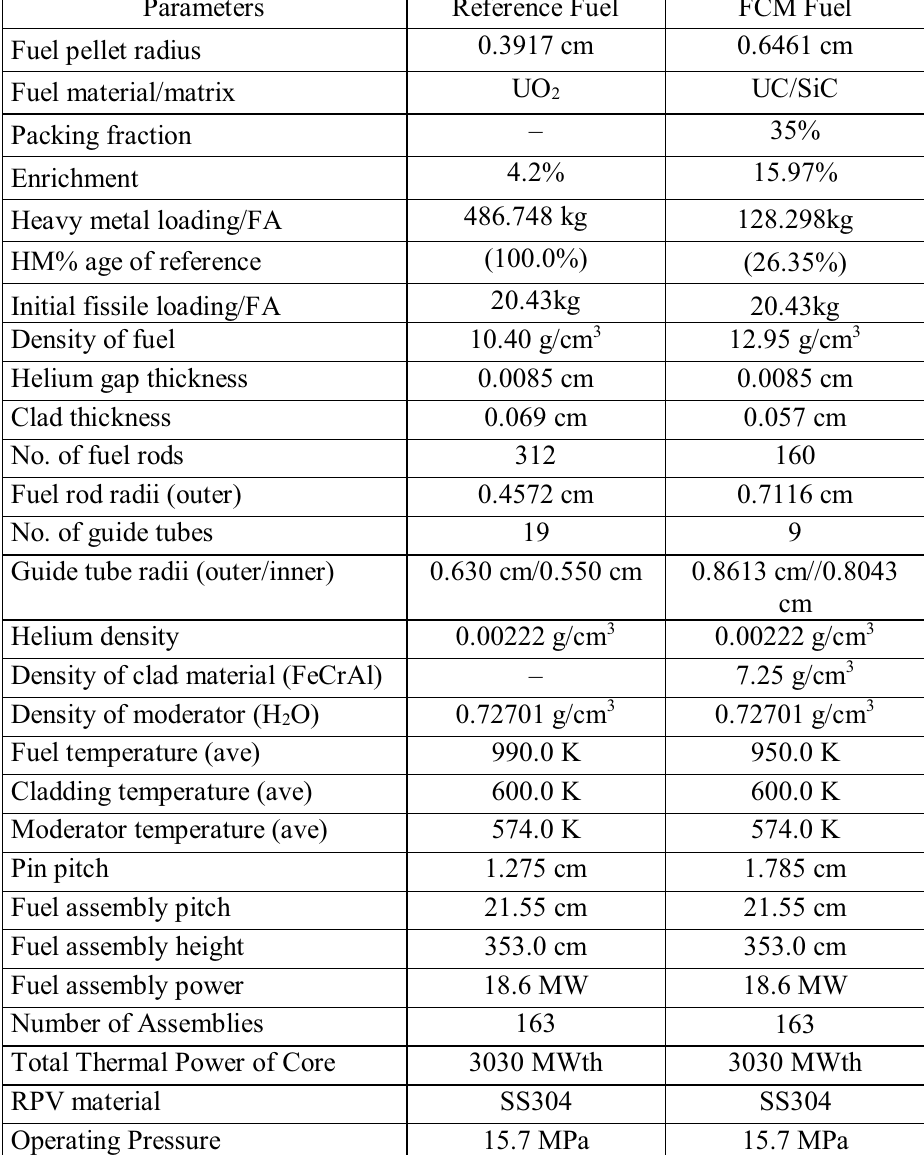
Table I. Description of full core simulation